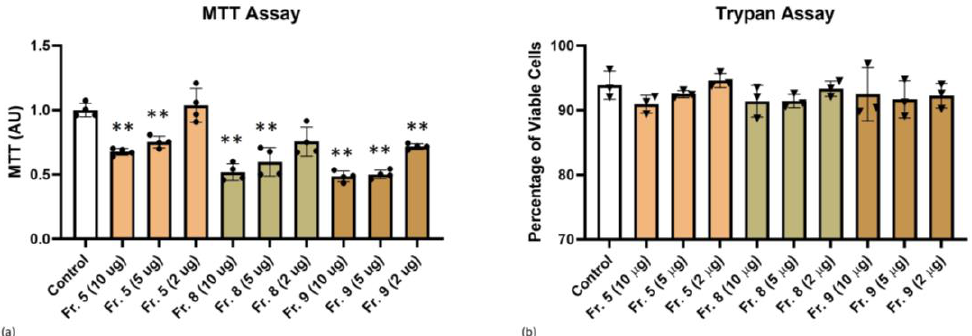
Figure 5. Determination of cell viability by ( a ) MTT and ( b ) Trypan blue assays. The THP-1 cells were treated with different concentrations of tomato-derived PDNVs (2, 5, and 10 µg/mL) separated into three visible fractions, namely Fraction 5 (Fr. 5), Fraction 8 (Fr. 8) and Fraction 9 (Fr. 9) by density gradient ultracentrifugation (DGUC). The treatment was performed for 48 h while control was untreated. ANOVA test followed by Dunnett’s post-hoc analysis. The level of significance was p ≤ 0.05 or p ≤ 0.01 (**) versus control condition.